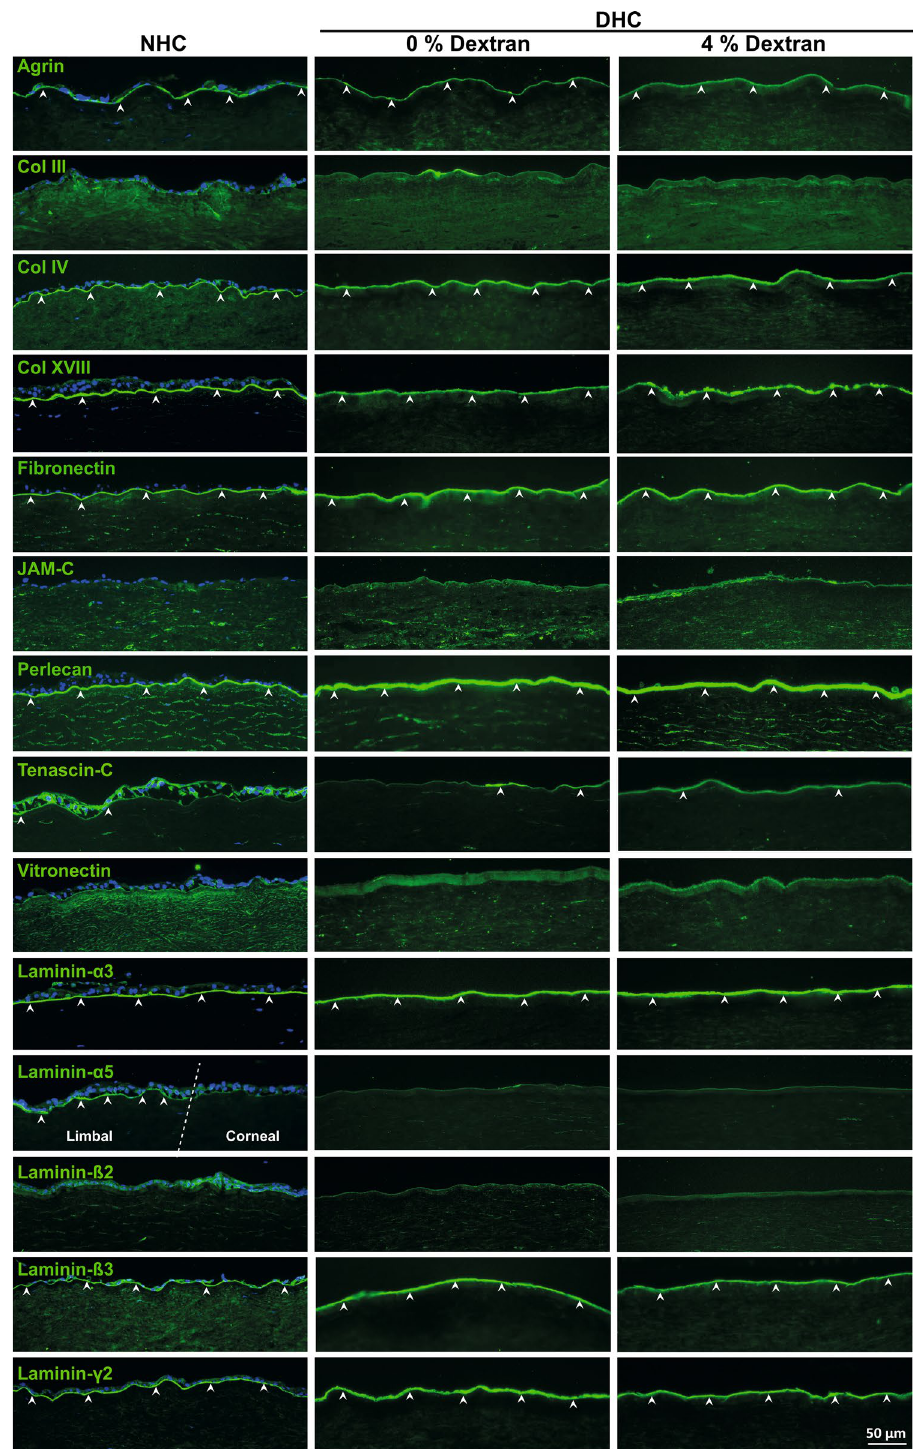
Figure 3. Extracellular matrix (ECM) composition of decellularized human cornea (DHC). Immunostaining analysis of various (ECM) and basement membrane (BM) molecules on the DHC (0 and 4% dextran) compared to the normal human cornea (NHC). The white dashed line marked the boundary between the limbal and corneal tissue in laminin (LN) α5 staining of NHC. Arrowheads indicating the expression of ECM and BM molecules. Nuclei counterstained with 4 ′ ,6 ‐ diamidino ‐ 2 ‐ phenylindole (blue). Col Collagen, JAM-C junctional adhesion molecule